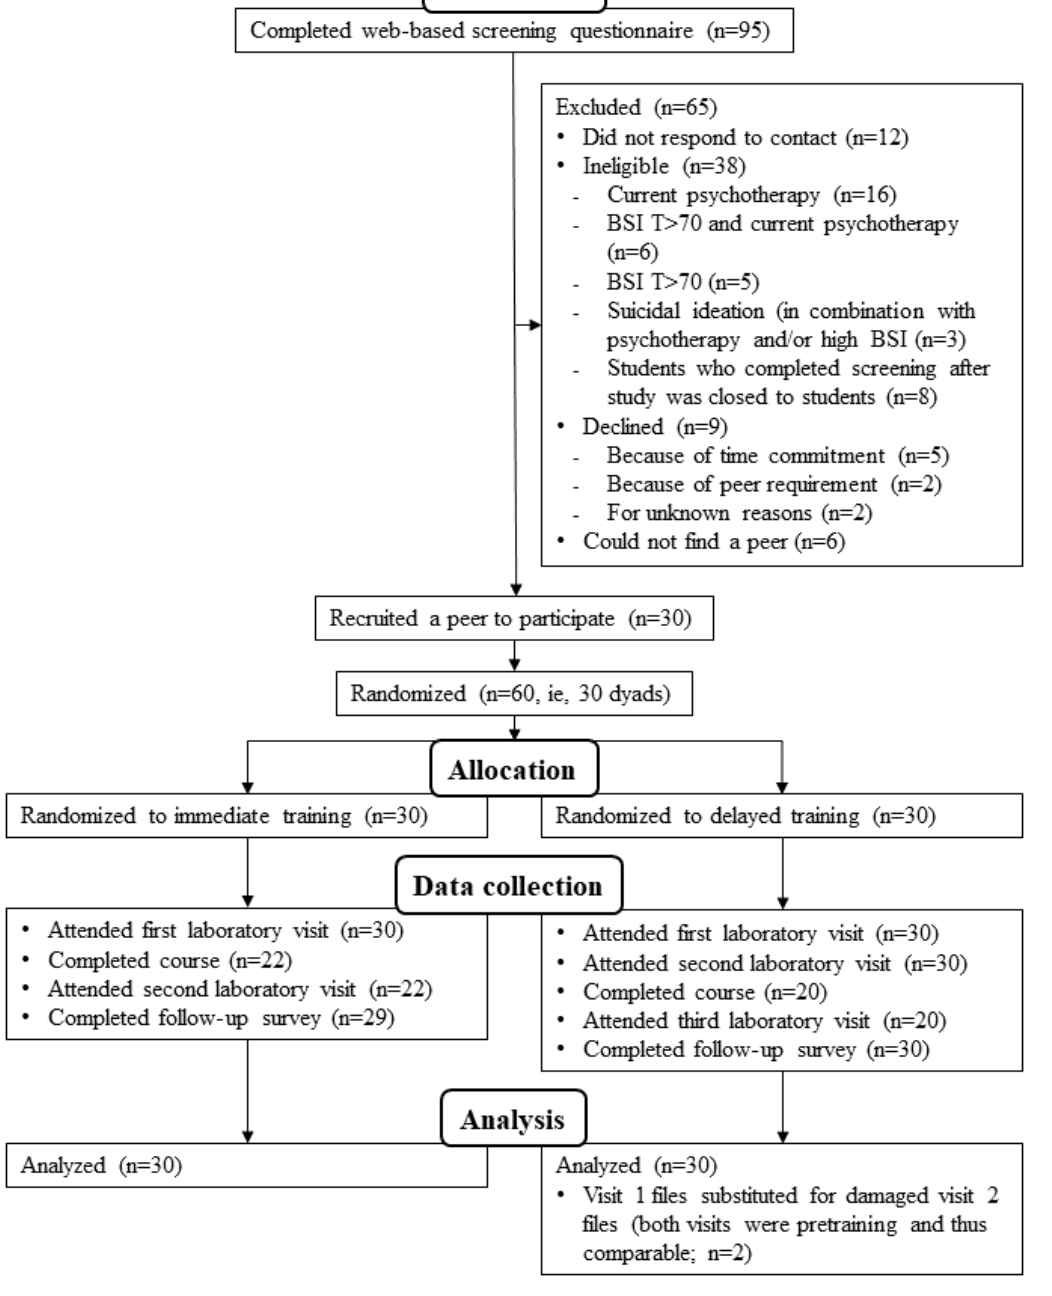
Figure 1. Study flow diagram. N denotes the total number of individuals, not the number of dyads. BSI: Brief Symptom